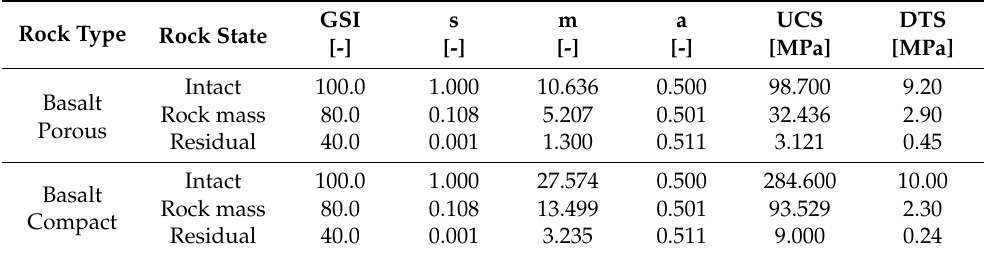
Table 5. Parameters of the Hoek–Brown failure envelope (s, m, a) for the intact rock, rock mass, and residual